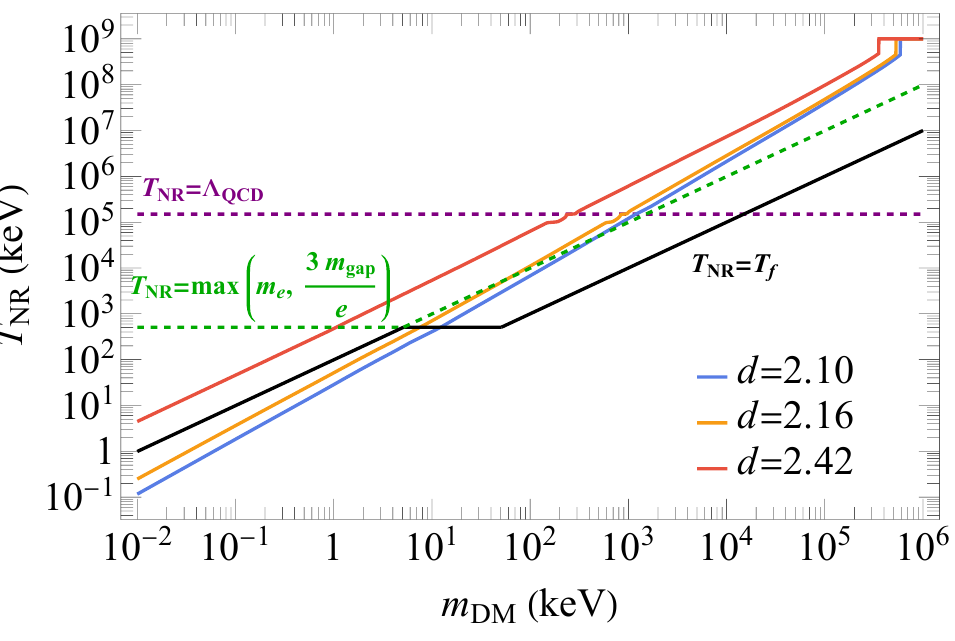
Figure 4 . T NR as a function of m DM with a couple of choices of d for the parameters chosen in the left panel of figure 3 (i.e. r = 0 . 1 ). The green-dashed curve shows the temperature when one of the two SM initial states decouple from the thermal bath. The black solid line shows the temperature when either all of the SM initial states decouple or when we switch to “hadronic” production. For data points below the black solid line, the transition into the non-relativistic phase occurs after the end of